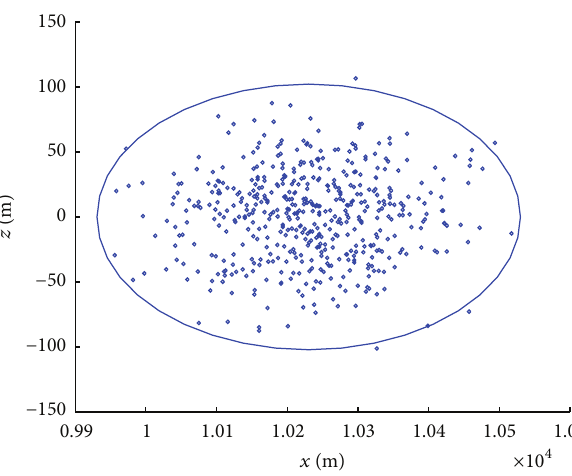
Figure 14: The equiprobable error ellipse of impact